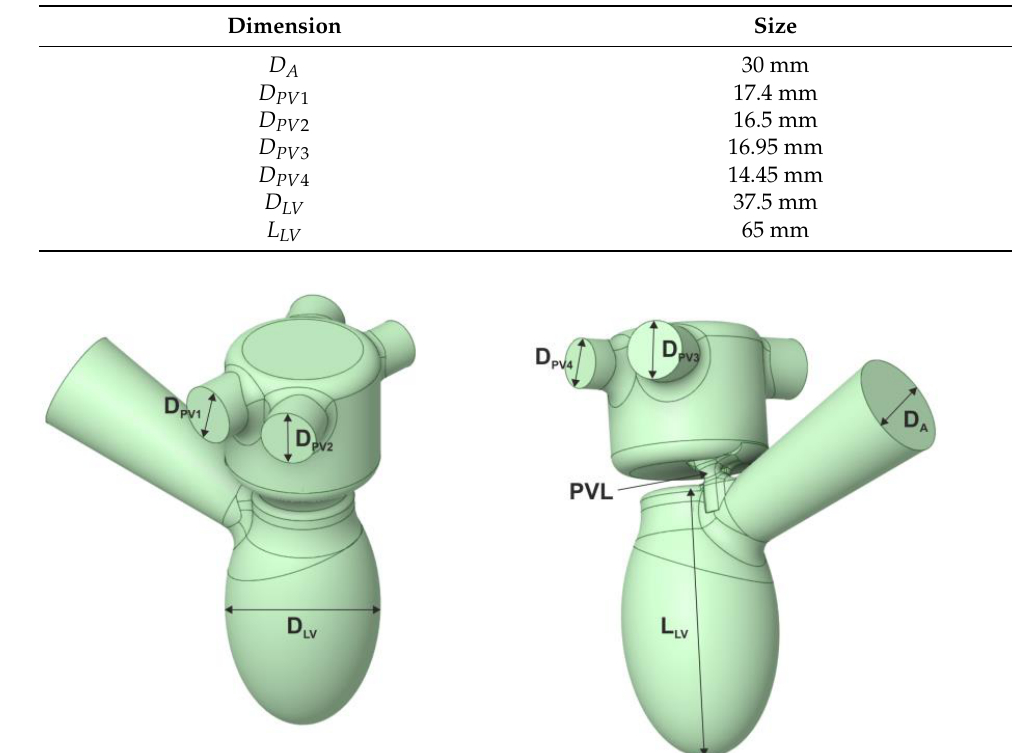
Table 1. Dimensions of the models of the left ventricle.